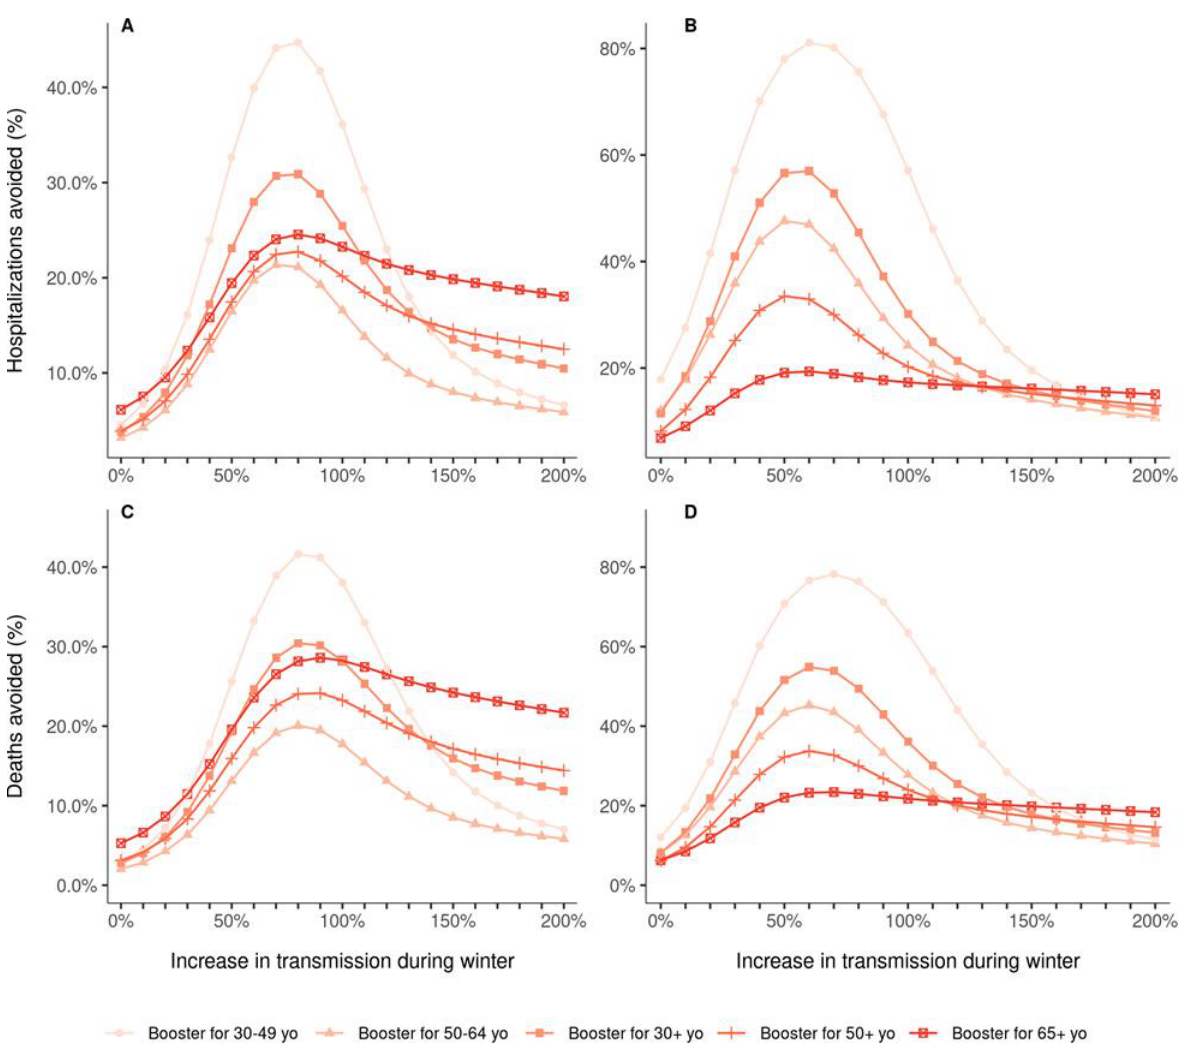
Figure 4. Proportion of hospitalizations ( A , B ) and deaths ( C , D ) avoided by 10 million booster shots compared to a baseline scenario of no booster shots, depending on the targeted age groups and the level of transmission during the winter, over the period from 1 September 2021 to 1 March 2022. In all strategies, primary vaccination is stopped on 1 September 2021. The increase in transmission starts on 20 September 2021 and is relative to the mean transmission levels during the summer 2021 (Reff = 1.0). ( A , C ) Vaccine efficacy decreased only for people aged 65 years and older. ( B , D ) Vaccine efficacy decreased for all age groups.